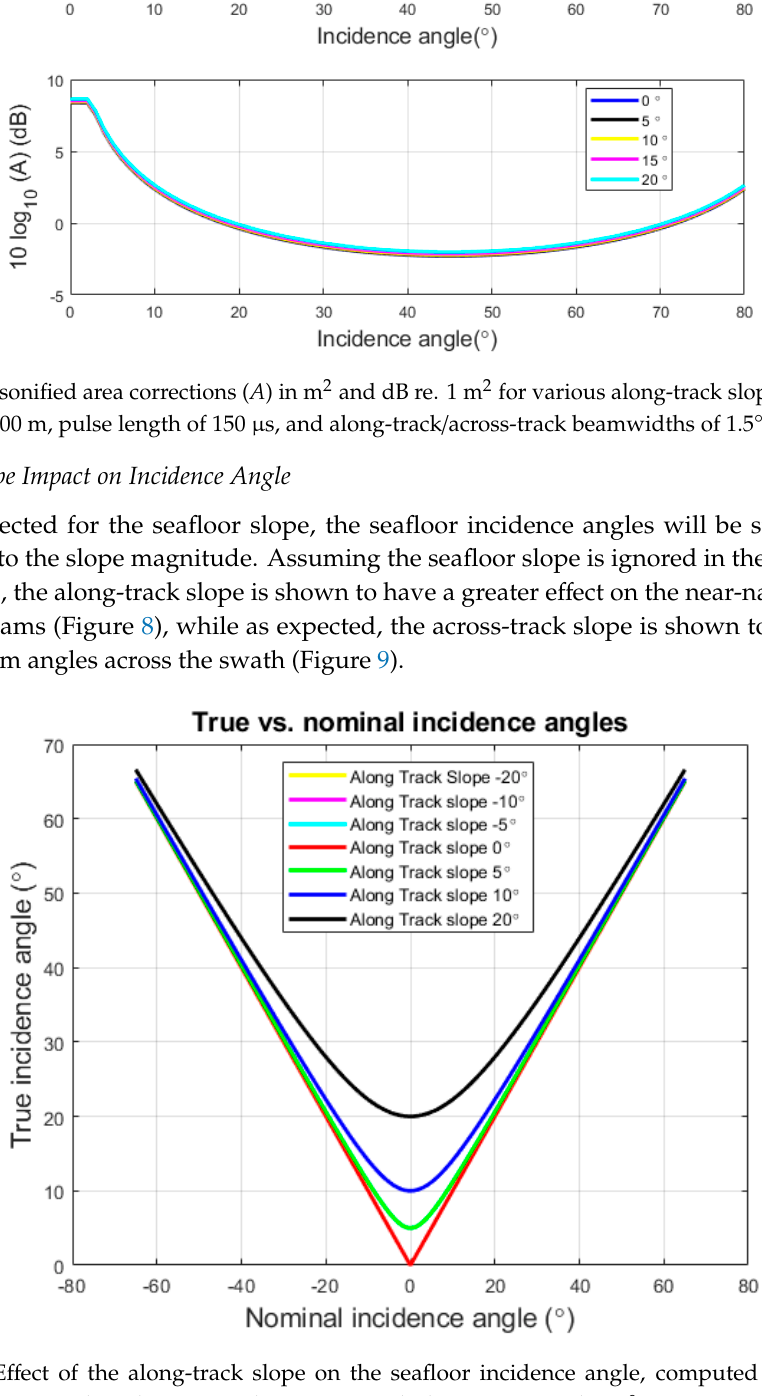
Figure 9. Effect of the across-track slope on the seafloor incidence angle, computed for various angles, relative to nadir. Along-track slope is assumed as 0°.